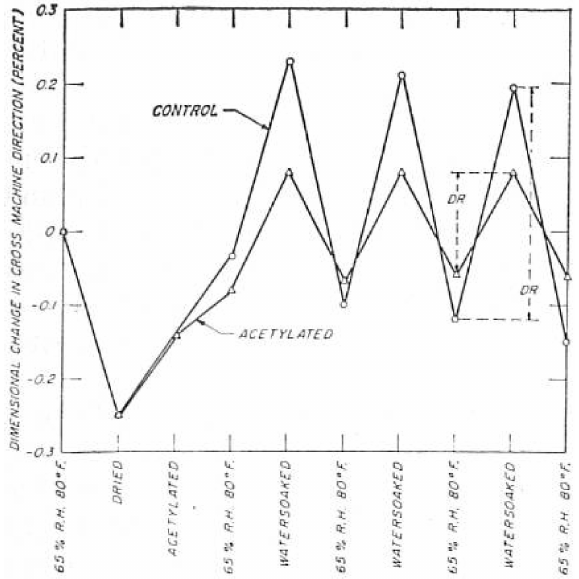
Figure 17. Dimensional changes in control and acetylated Masonite hardboards under various moisture conditions